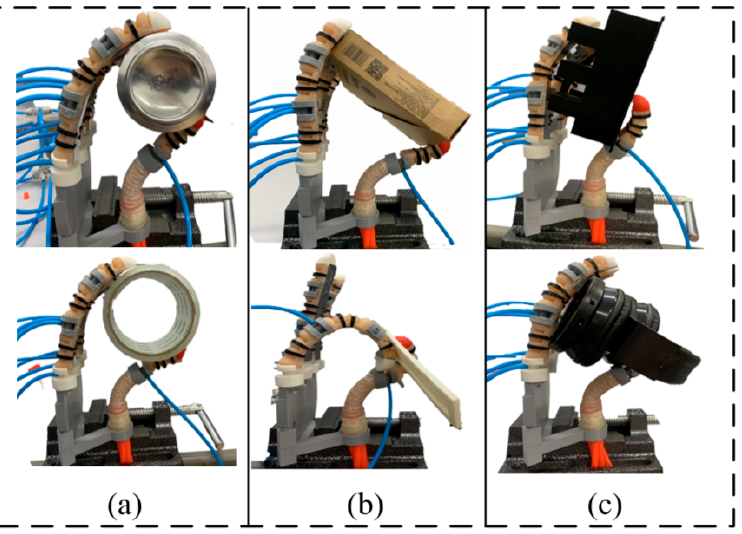
Figure 19. Soft bionic hand grasping experiment: ( a ) Cylinder; ( b ) Cuboid; ( c ) Irregular object.